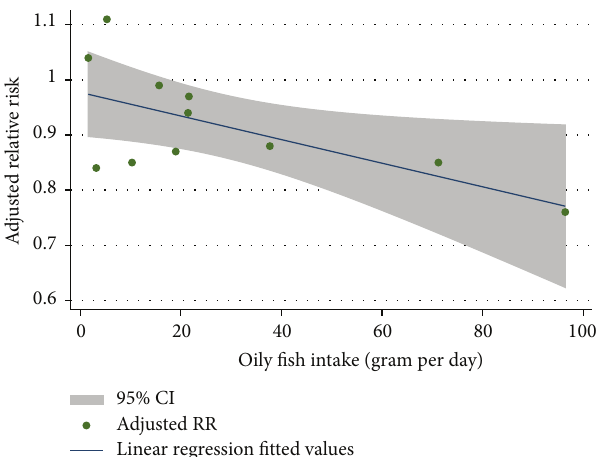
Figure 4: Linear regression of adjusted RR of T2D versus oily fish intake. The upper and lower bands denote the 95% confidence interval on mean of the predicted value, 𝑅 2 = 0.40